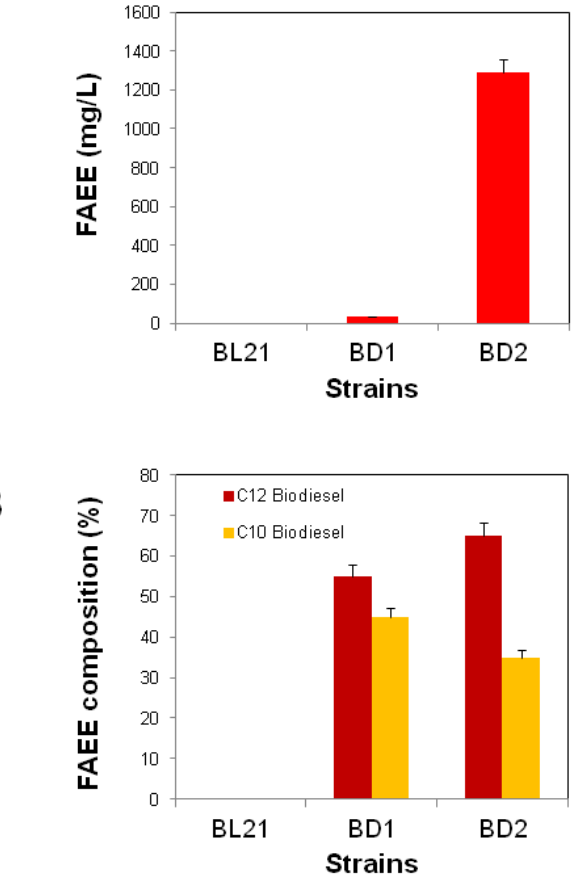
Figure 3. Biodiesel production in engineered Escherichia coli . ( A ) Total fatty acid ethyl ester production. ( B ) Composition of fatty acid ethyl ester. Values and error bars represent the mean and standard deviation of triplicate experiments. C12 and C10 biodiesel represent dodecanoic acid ethyl ester and decanoic acid ethyl ester, respectively.